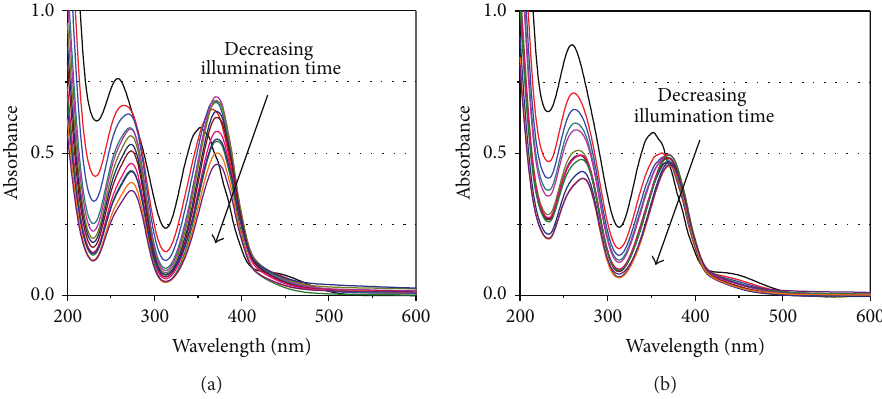
Figure 12: The absorbance spectrum of K 2 Cr 2 O 7 aqueous solution with (a) P25 Aeroxide TiO 2 and (b) TiO 2 synthesized with 10% AC as photocatalysts as a function of illumination time. The solar simulator with xenon 150W lamp with a filter was used as a light source.